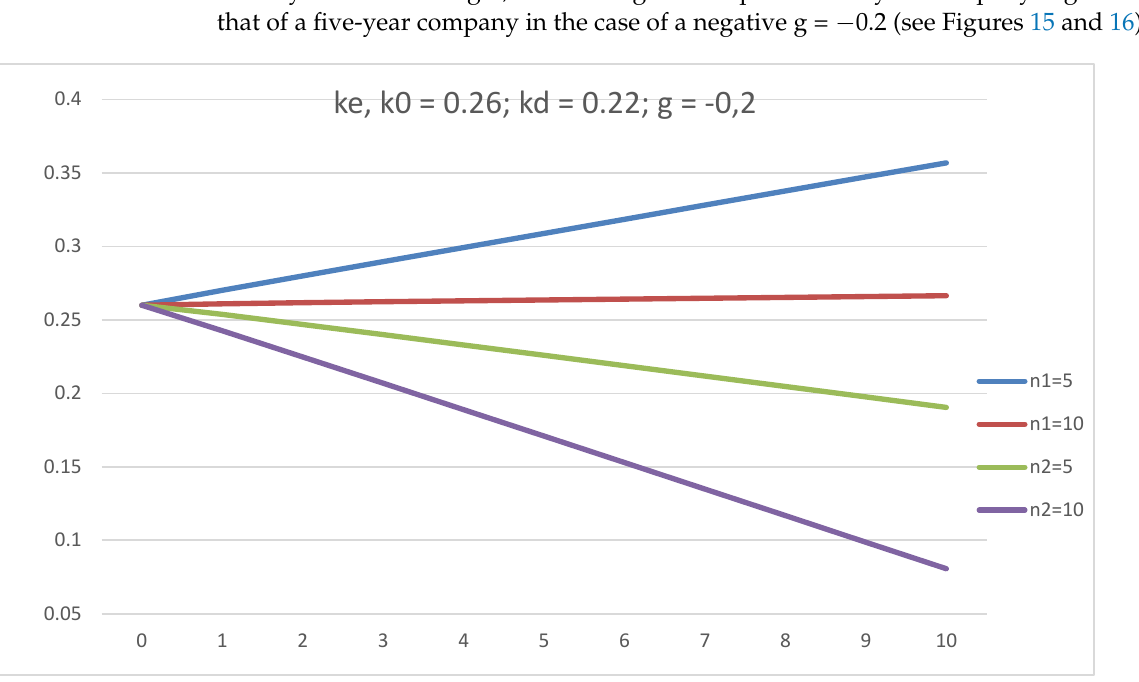
Figure 16. The dependence of equity cost, ke, on leverage level, L, in GBFO theory with payments of tax on profit at the end of periods (1) and advance payments (2) at k 0 = 0.26; k d = 0.22; t = 0.2; g = 0.2, for five-year and ten-year companies. 3.3.5. Summary of Results The curves, (WACC–g)(L), demonstrate the decrease of WACC–g with L at all g. The curves, (WACC–g)(L), decrease with g.